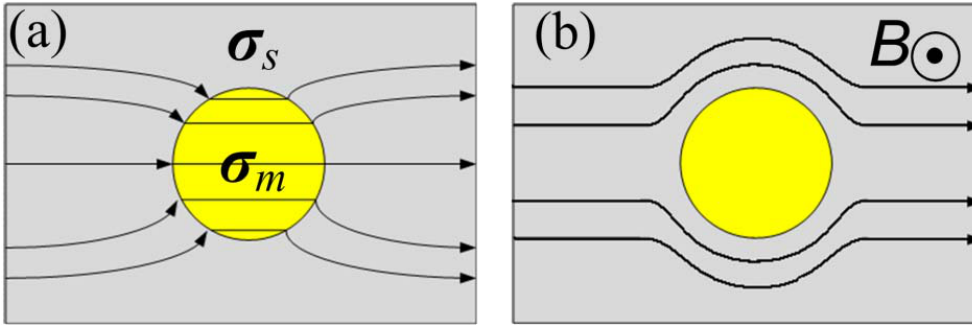
Figure 2. Current distribution in a semiconductor/metal hybrid structure. The gray and yellow areas express the semiconductor and metal, respectively. The dark lines show the paths of current. ( a ) At low magnetic fields, the current is parallel to the electric field E and the metal acts as a short circuit; ( b ) At high field, the current is mainly flowing in the semiconductor, the hybrid acts as an open